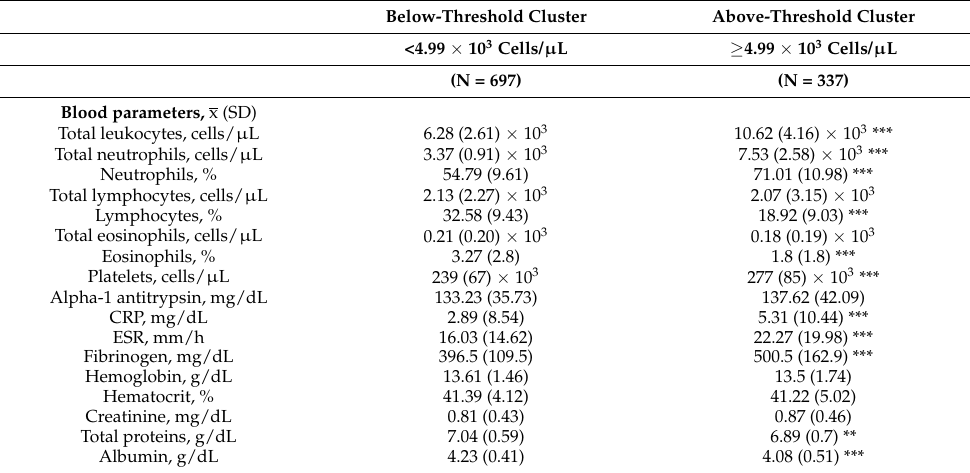
Table 5. Inflammatory and nutritional parameters in the two clusters of